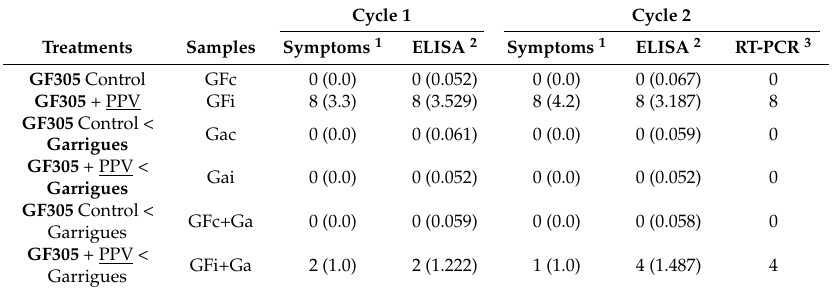
Table 1. Behavior against PPV in the plant material assayed. The samples assayed included control (GFc) and infected (GFi) “GF305” peach showing strong sharka symptoms; control (Gac) and infected (Gai) “Garrigues” almond; and control “GF305” grafted onto “Garrigues” almond (GFc+Ga) and infected “GF305” grafted onto “Garrigues” almond (GFi+Ga). The plant material evaluated appears in bold